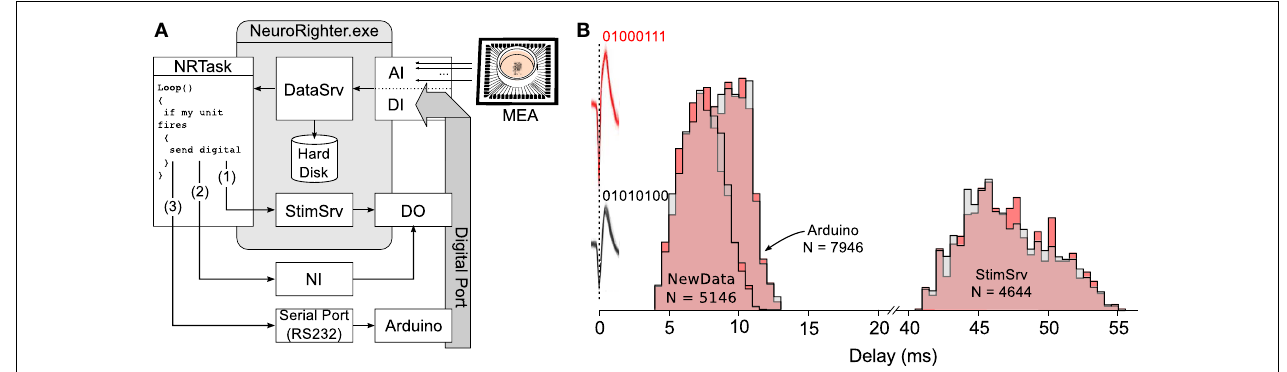
NewData event, or an Arduino board. Digital signals were then, recorded though NeuroRighter’s digital input port. (B) Normalized histogram of time delays from spikes produced by the two units of interest (action potential waveforms are shown in pink and gray and occur at 0ms) to the recorded digital signals produced by the plugin to encode the units (01000111 or 01010100). Delay histograms are shown for each unit (pink and gray) and the three different hardware options. N is the number of spikes recorded for each hardware